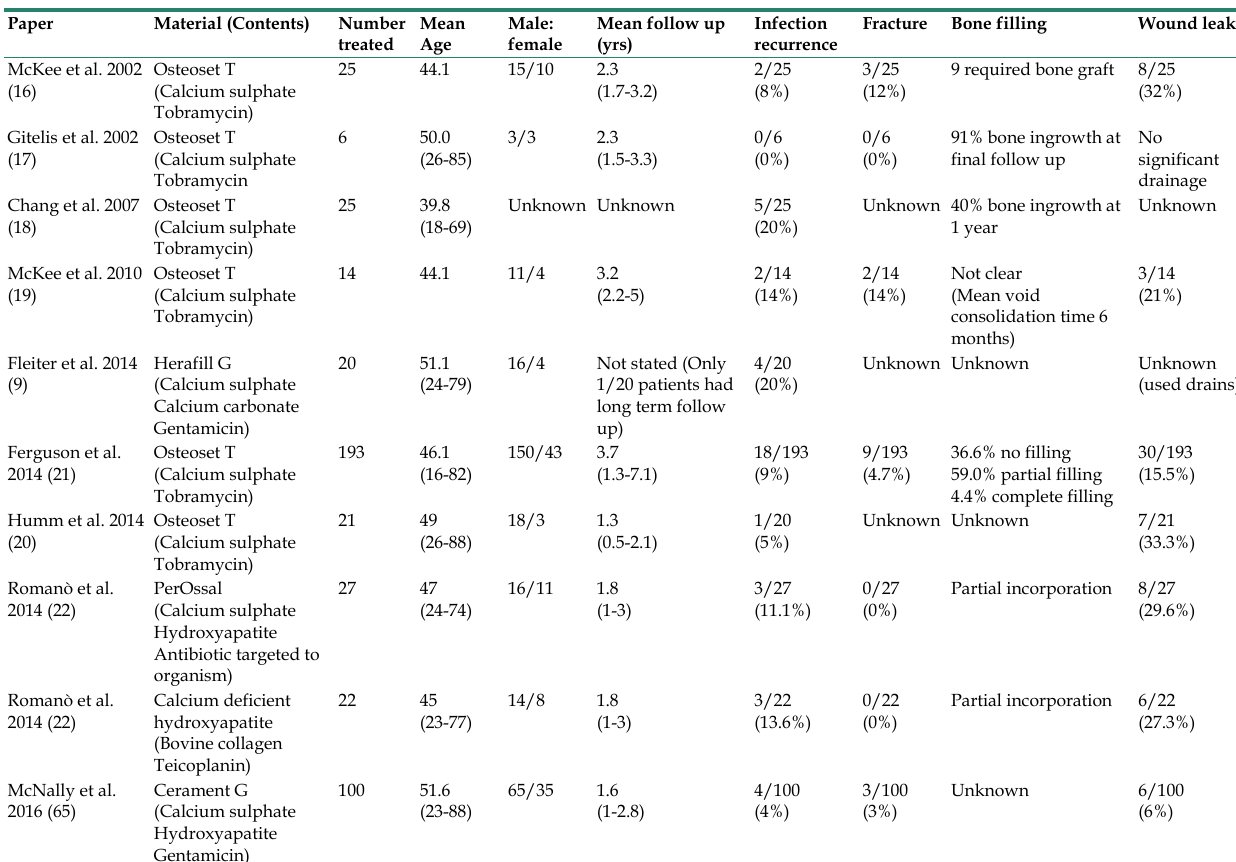
Table 5. Papers looking at outcome of long bone osteomyelitis in humans with ceramic antibiotic carriers.